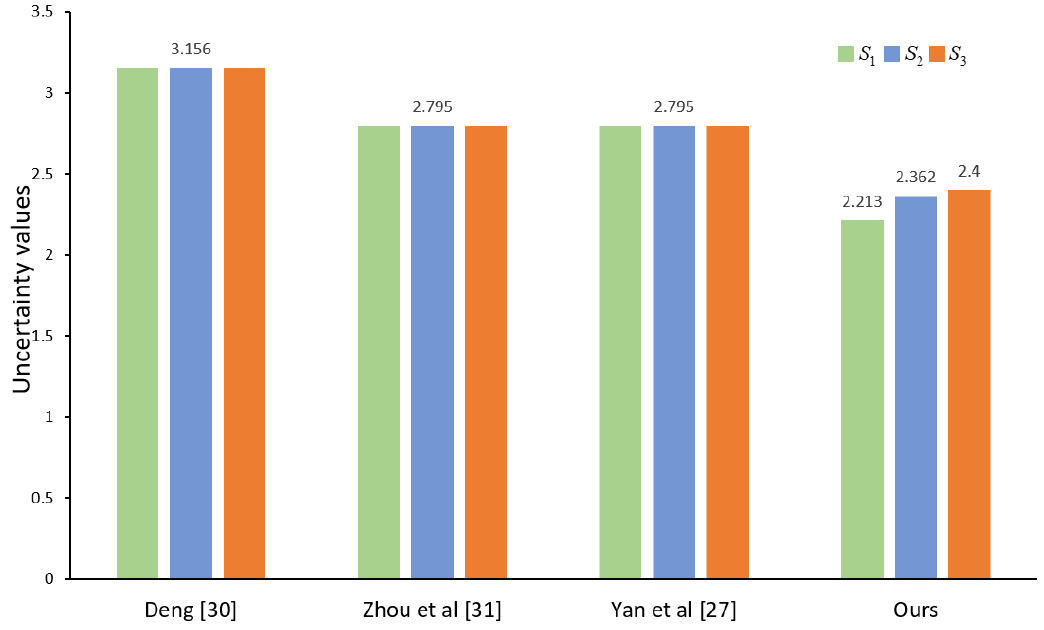
Figure 2. Uncertainty values of four